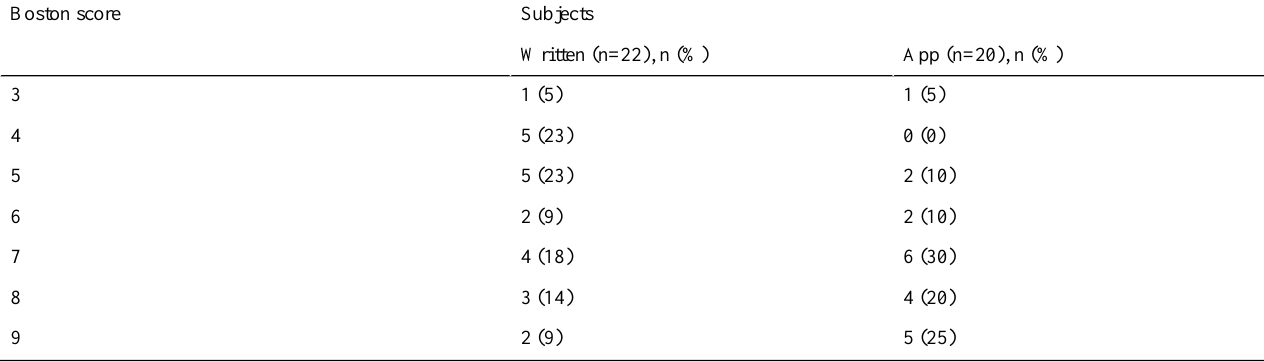
Table 2. Boston scores for app and written instruction